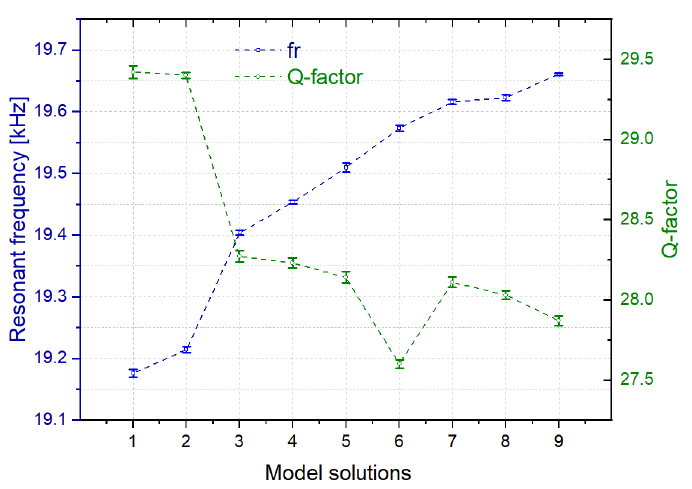
Figure 13. Mean values and deviations of the resonant frequencies and Q-factors of the sensor immersed in different model solutions of grape must at 20 °C.